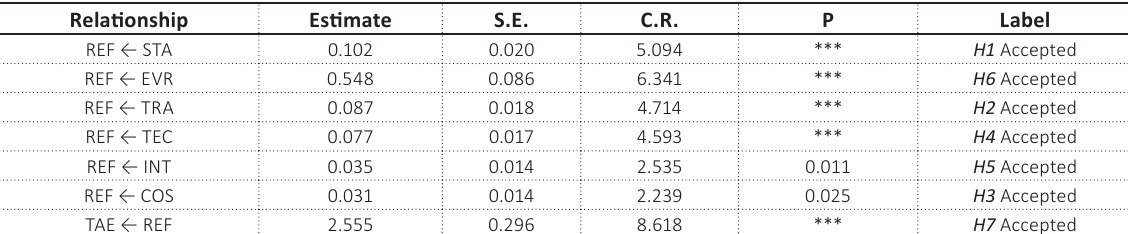
Table 5. Results of hypotheses testing